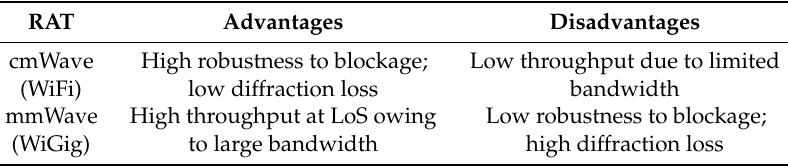
Table 1. Advantage and disadvantage of different